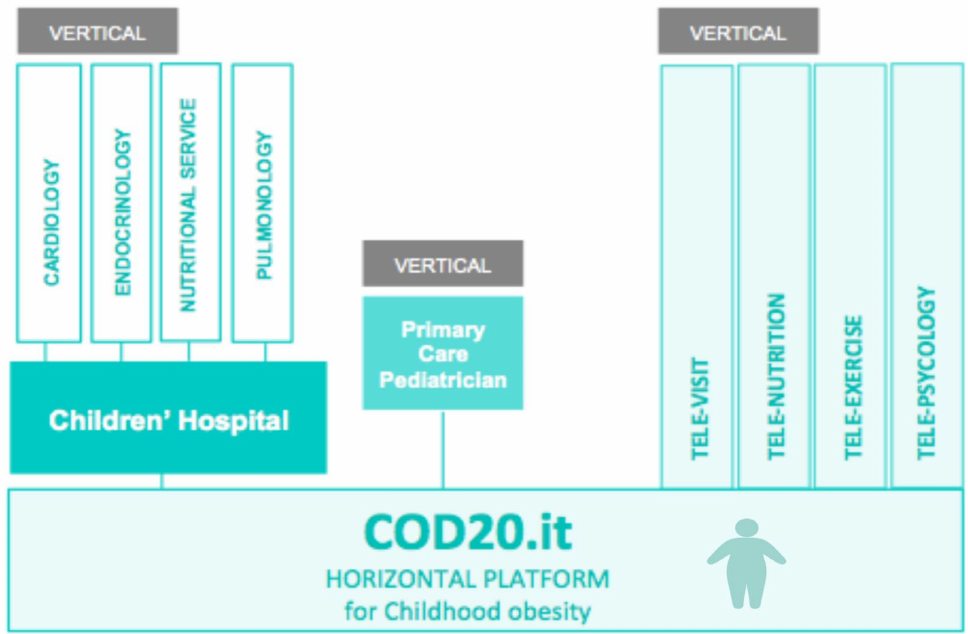
Figure 3. Proposal of virtual platform, using the COD20 model [25], as a novel approach to childhood obesity surveillance (created with BioRender.com, accessed on 16 October